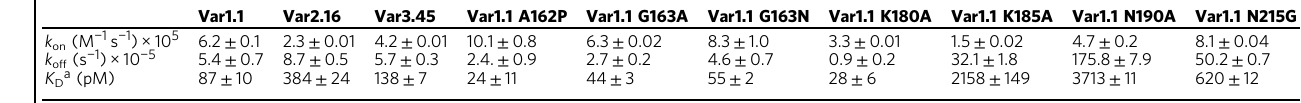
Table 1 Binding kinetic values determined for mAb 1A12 by surface plasmon